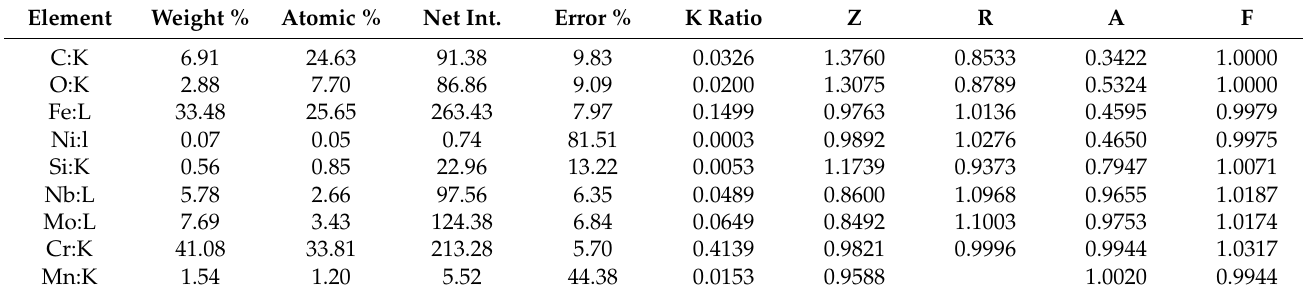
Figure 10. EDS measurement of the first point for specimen No. 1. Table 3. Chemical composition as the result of EDS analysis in specimen No. 1 (first point).